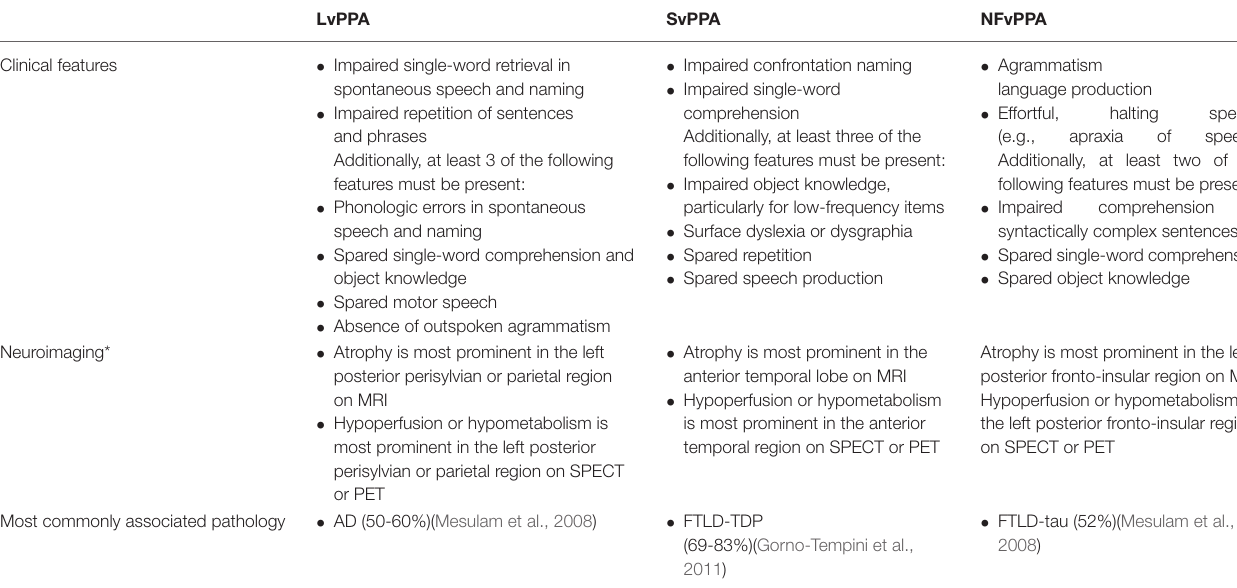
TABLE 1 | Classification of primary progressive aphasia (PPA)